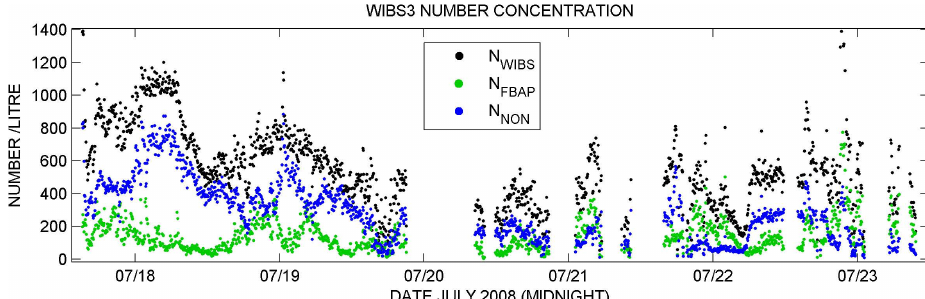
Fig. 9. Above-canopy time series of N WIBS , N FBAP and N NON in July 2008. Gaps represent instrument downtime.